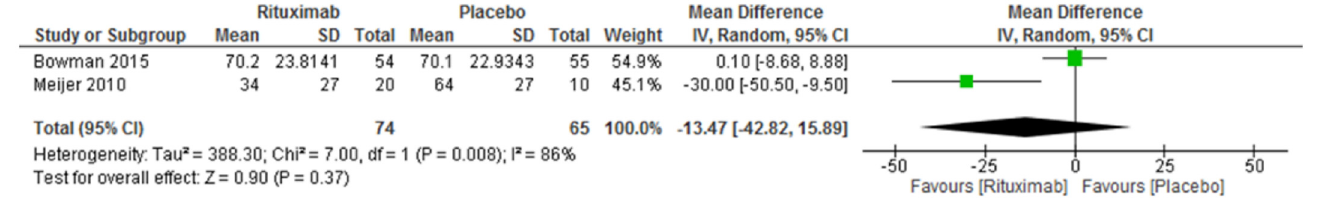
Fig 5. Rituximab X Placebo. Meta-analysis of the outcome oral dryness (VAS) at week 24.